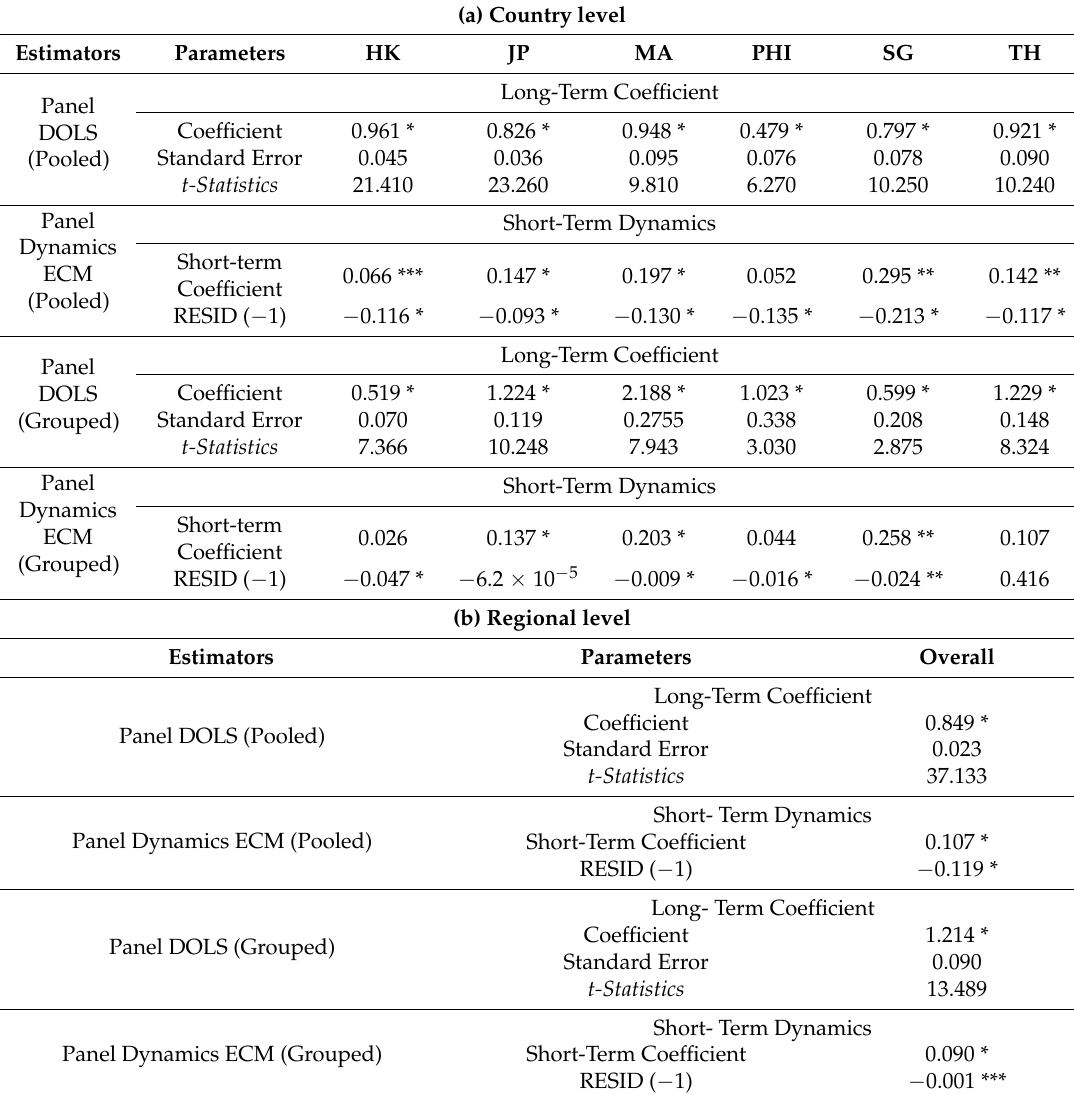
Table 4. Results for panel dynamic ordinary least squares test and panel error correction Models: